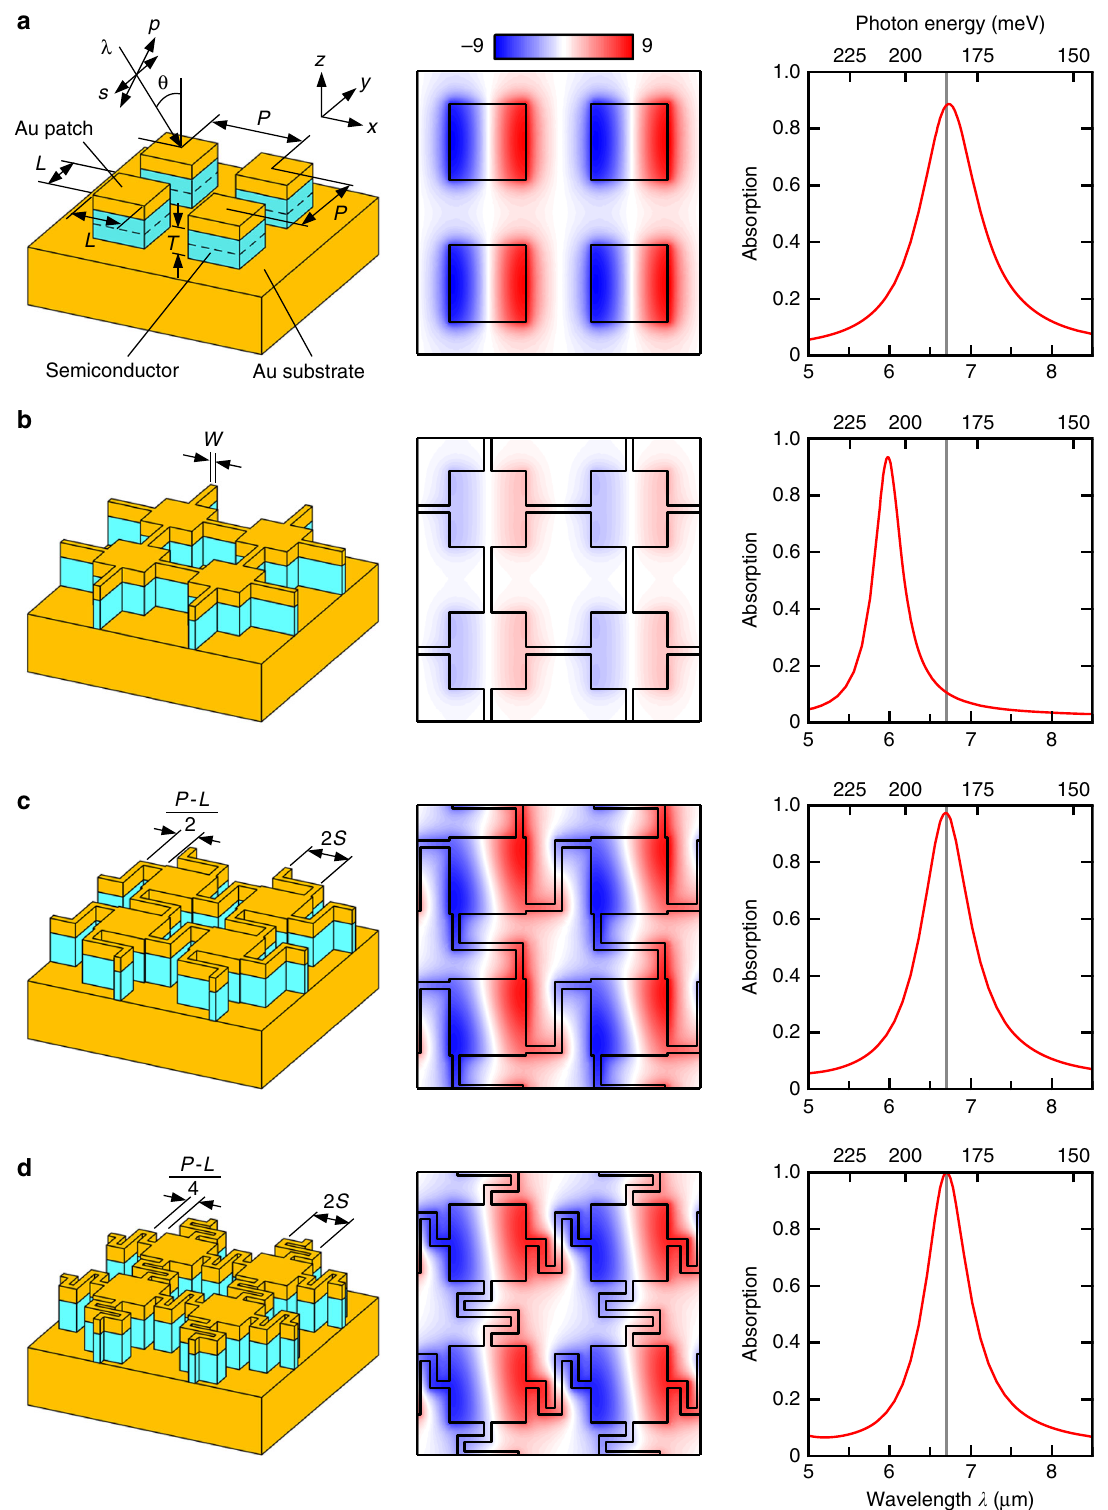
Fig. 1 Structure (left), E z distribution at λ = 6.7 μ m (center) and absorption spectra (right) of the arrayed optical patch antennas. a Array of isolated antennas serving as the fundamental structure for this model study. b – d Antennas connected with b straight, c Z-shaped ( S = 0.45 μ m), and d S-shaped ( S = 0.38 μ m) wires. The schematics show the de fi nitions of the coordinate system, incidence angle, polarization, and dimensions. L = 1.08 μ m, P = 2.0 μ m, T = 200 nm, and W = 100 nm. The vertical lines in the absorption spectra represent the sensitivity peak wavelength of QW ( λ = 6.7 μ m). The center column shows the snapshots of E z at its maximum moment on the center xy plane of the semiconductor layer (broken lines in the schematic of a ) for x polarization, θ = 0°; the value is normalized by the incident electric fi